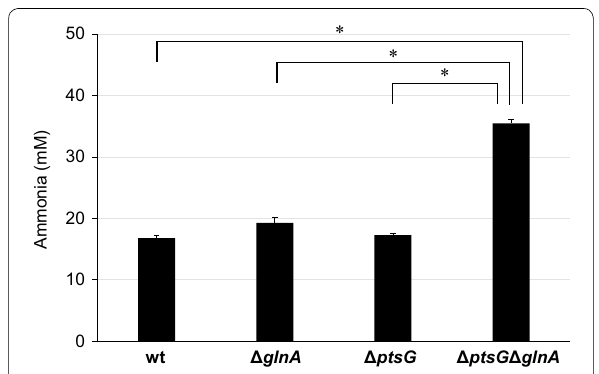
Fig. 5 Ammonia production from pretreated okara by engineered E. coli strains. Ammonia was produced by incubating cells in the pretreated okara solution at 37 °C for 26.5 h. Values are expressed as the mean SD (n 3). Statistical significance was determined by ± = Tukey’s test (*P <